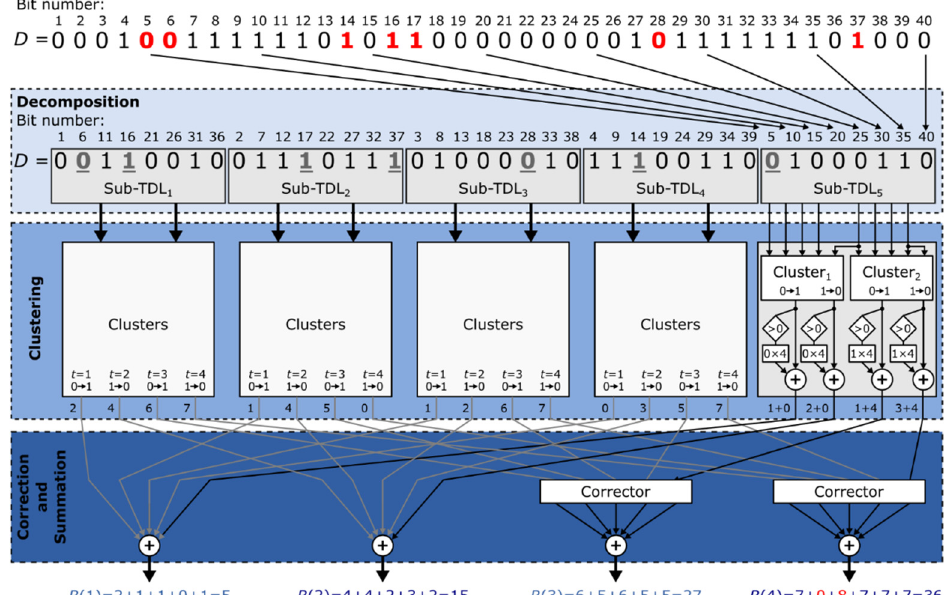
Figure 5. Pre-encoder with decomposition and clustering. Decomposition divides input data ( D ) to several sub-sequences (sub-TDLs) to eliminate bubble errors. Clustering is used to identify transitions occurrence in small chunks (four bits, c = 4) of the sub-TDLs. An additional (5th) cluster’s input is used to identify boundary transitions (between clusters). Correction and summation merge results from all clusters. Correctors correct the result when the given transition was not detected in all clusters (e.g., value 8 is added to R (4)).